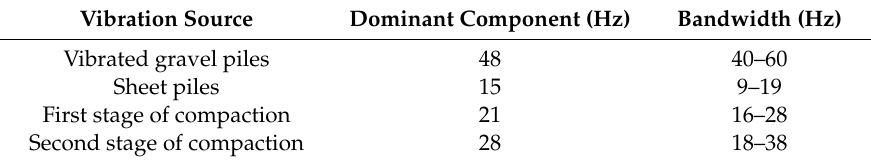
Table 1. Summary of the obtained frequencies from the presented sources of